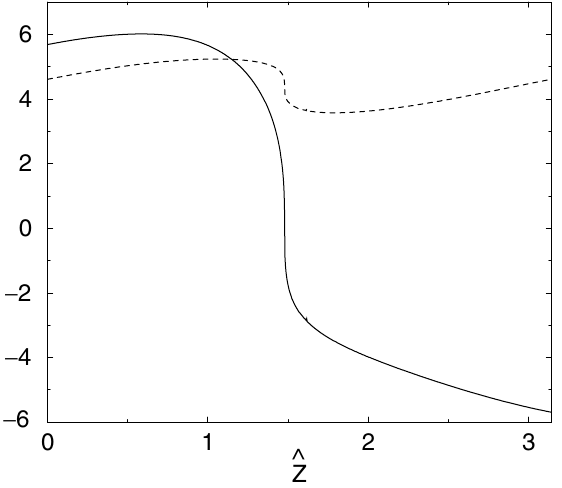
FIG. 6. A concrete example for (cid:22) (cid:1) 1 : 0 . Solid line: B (cid:1) (cid:4) (cid:5) (cid:22) (cid:1) 1 : 0 ; ^ zz (cid:6) ; ^ zz (cid:2) as a function of ^ zz ; dashed line: (cid:4) (cid:5) (cid:22) (cid:1) 1 : 0 ; ^ zz (cid:6) as a function of ^ zz .